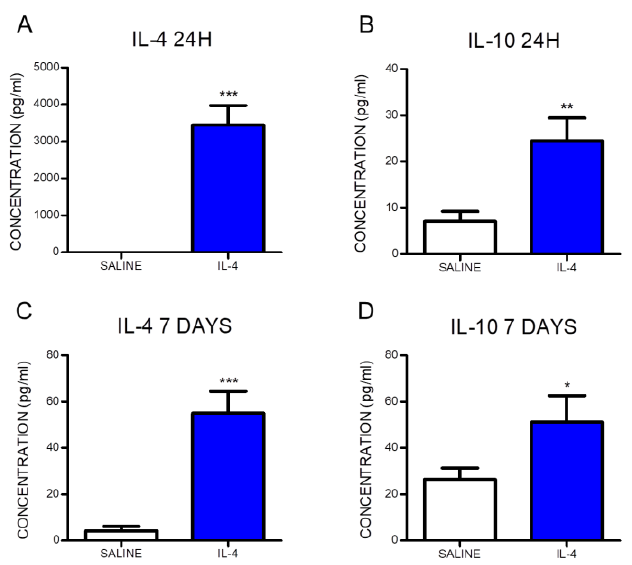
Figure 1. Interleukin-4 (IL-4) administered intraperitoneally reaches systemic circulation and promotes an elevation of the anti-inflammatory cytokine IL-10. The serum concentration of the cytokine IL-4 at 24 h ( A ) and 7 days ( C ) post-injury and IL-10 at 24 h ( B ) and 7 days ( D ) post-injury are significantly increased in the IL-4-treated rats. Values shown as mean ± SEM. * p < 0.05; ** p < 0.01; *** p < 0.001.